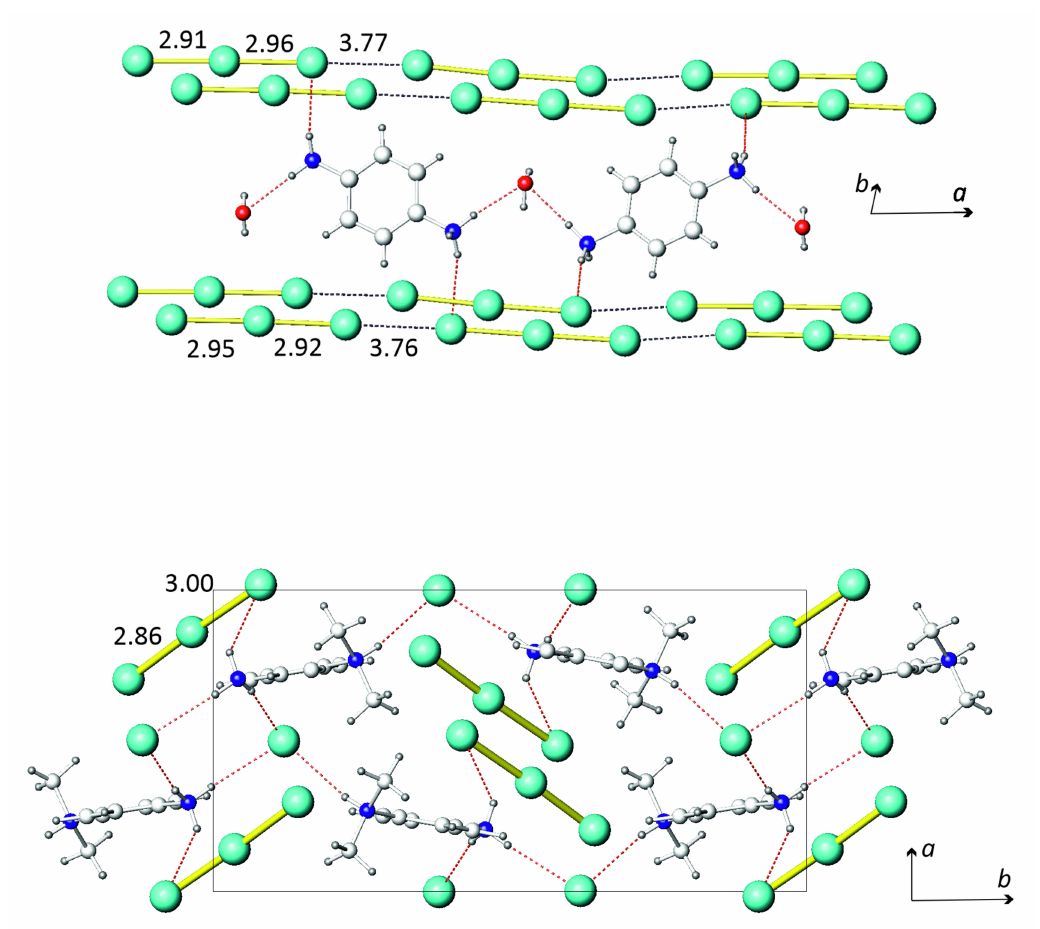
Figure 1. Crystal structures of 1 ( top ) and 2 ( bottom ). Iodine, green; oxygen, red; nitrogen, blue; carbon, light gray; hydrogen, dark gray. Hydrogen (N)H ··· O and (N)H ··· I bonds are shown as red dashed lines and I ··· I bonds as black dashed lines. The I–I and I ··· I interatomic distances are given in